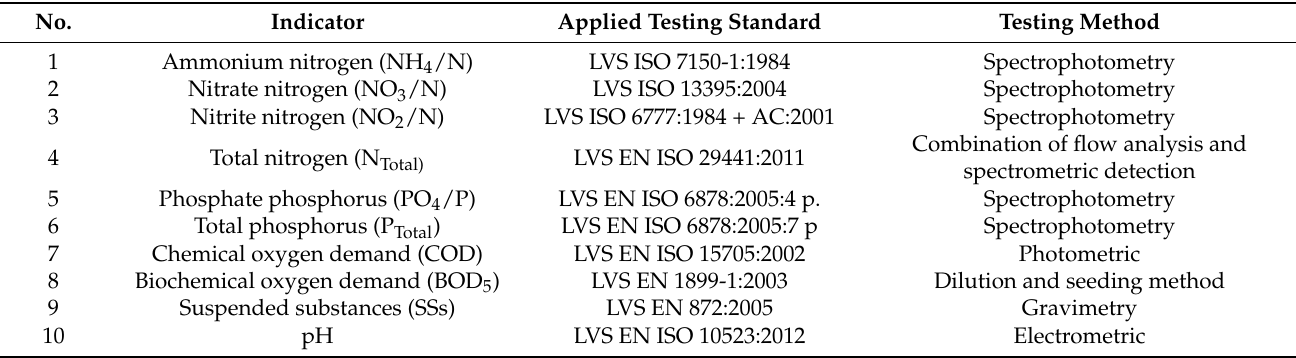
Table 1. The list of applied greywater testing methods for the determination of selected indicators and subsequent assessment of eutrophication risk factors.